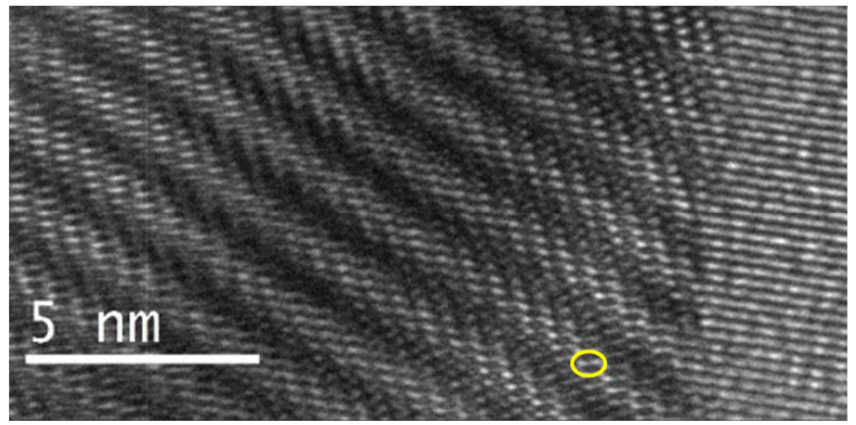
Figure 7. The transmission electron microscopy (TEM) of [Cu(12 ‐ crown ‐ 4) 2 ]I 5 : A deeper look into the structure.